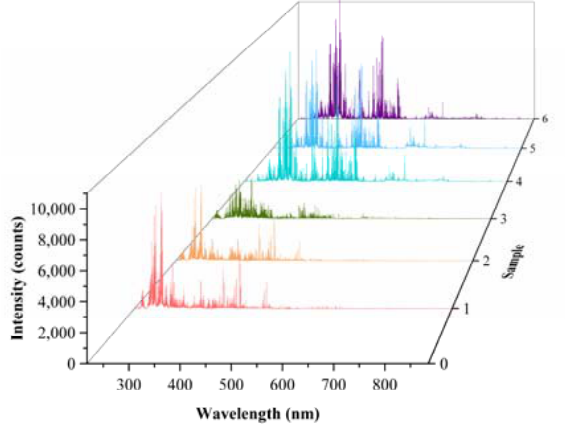
Figure 4. LIBS spectra of six aviation alloy samples.